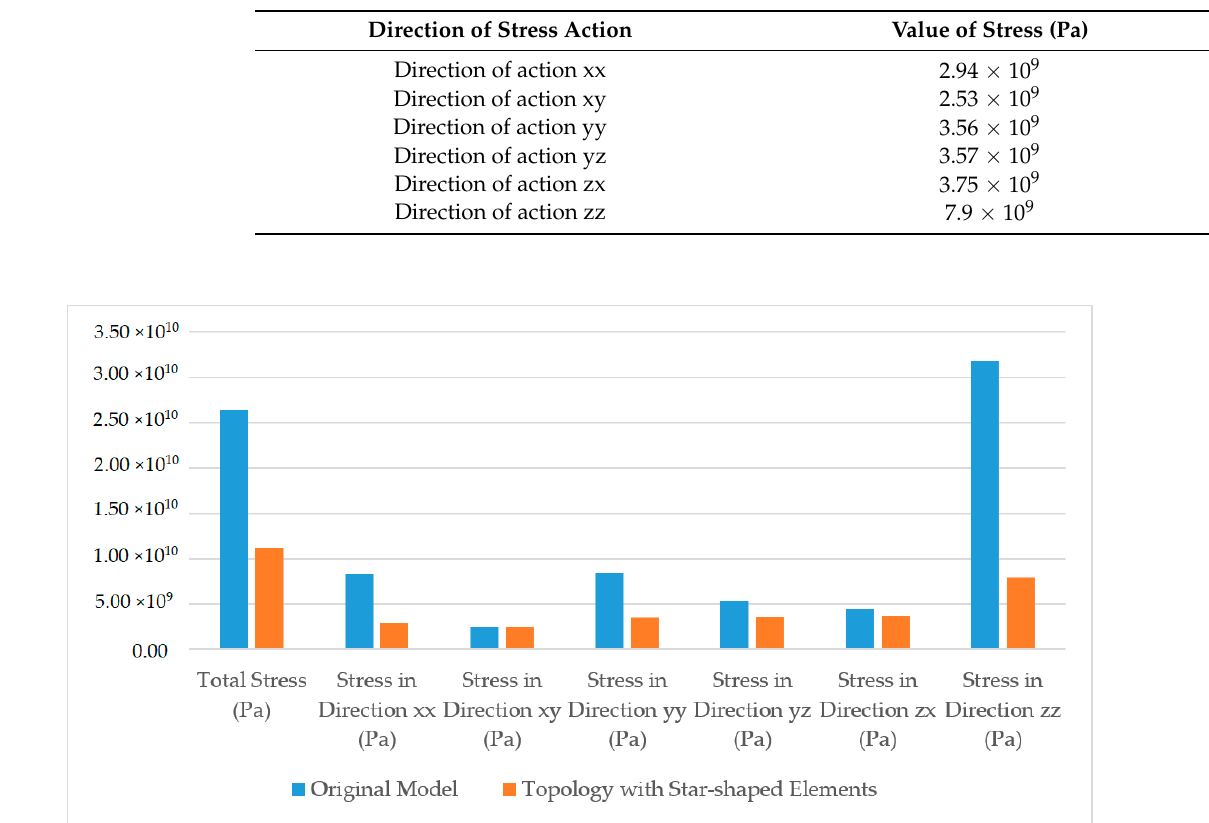
Table 2. Stress acting in the individual directions in the case of the proposed alternative.